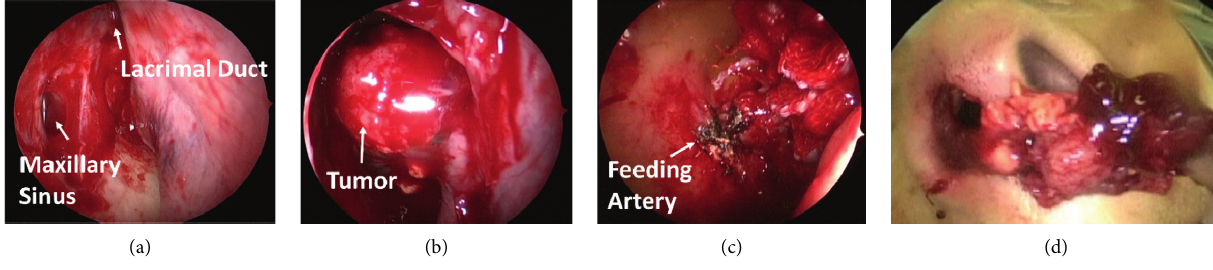
Figure 2: (a) Right maxillary sinus opened with endoscopic modified medial maxillectomy. (b) Tumor (3 × 2 cm) in the right maxillary sinus (with a 70 ° endoscope). (c) Bleeding from the feeding artery based on the anterior wall of the right maxillary sinus. (d) Feeding artery cauterized and unblocked tumor